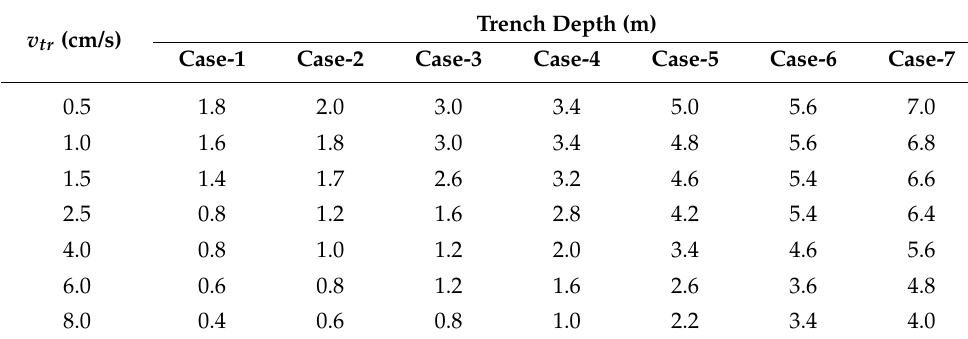
Table 4. Trench depths with different nozzle traverse rate and jetting